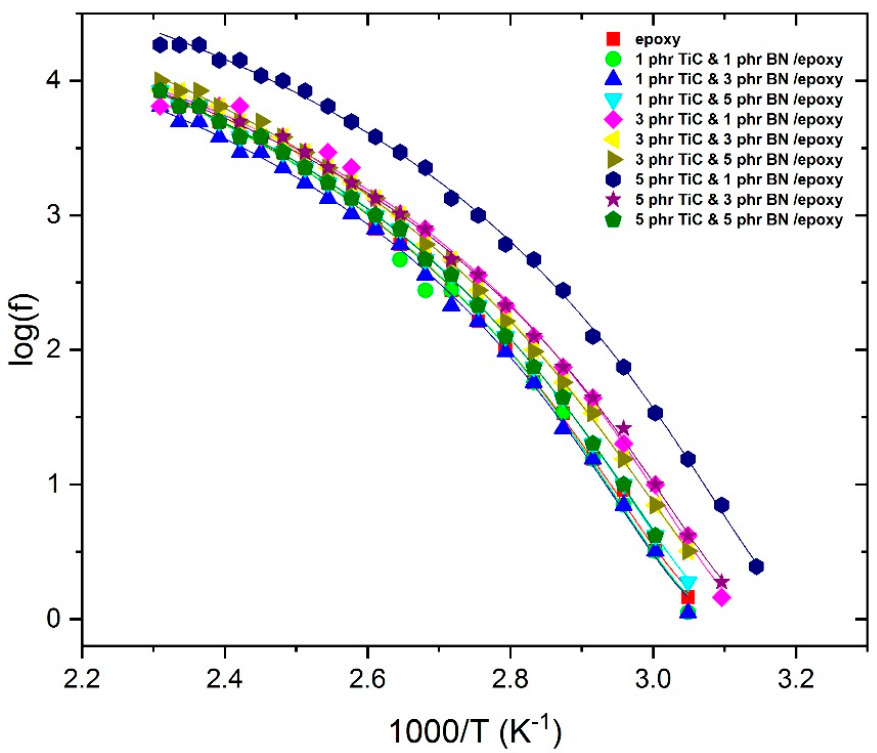
Figure 9. Dielectric loss peak position for α -relaxation, as a function of reciprocal temperature for all studied systems.